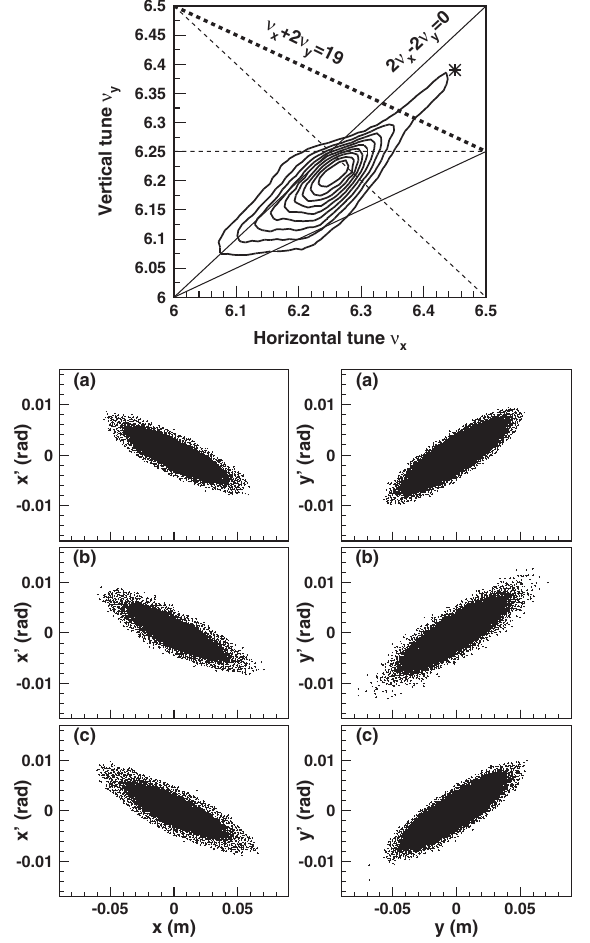
FIG. 11. Similar results to those in Fig. 10, calculated with a beam intensity of 850 kW in the case of the painting emittance of 150 π mm mrad: (a) without edge focus, (b) with edge focus, and (c) with the addition of QDTs to (b).